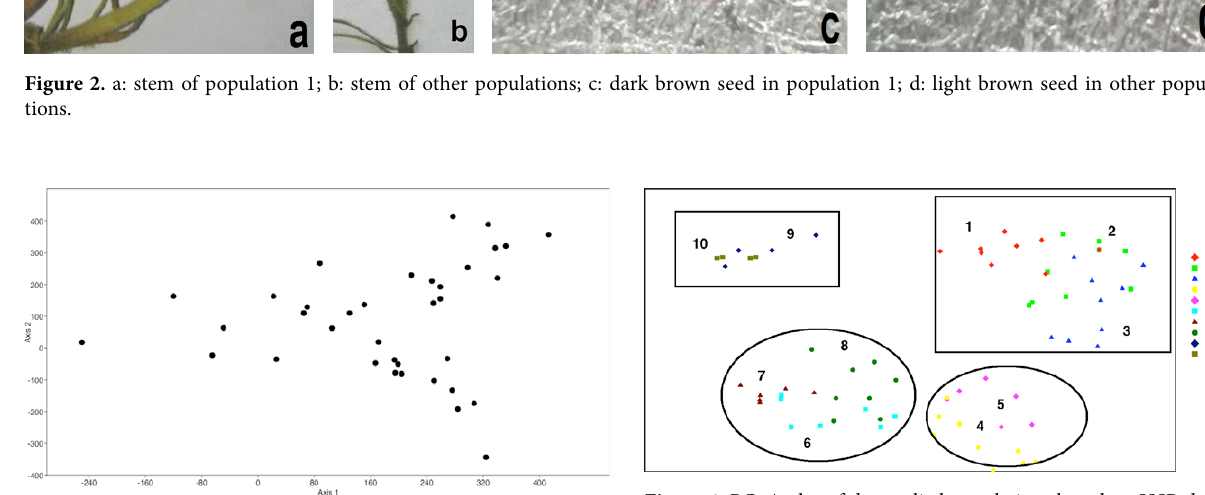
Figure 3. DCA plot of ISSR alleles of P. afra.